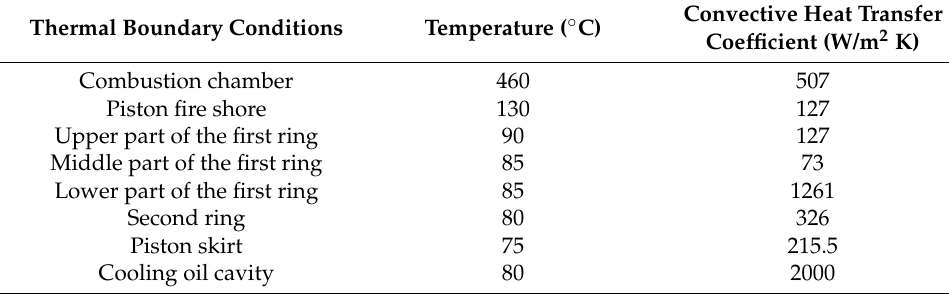
Table 2. Thermal boundary conditions of the different elements.